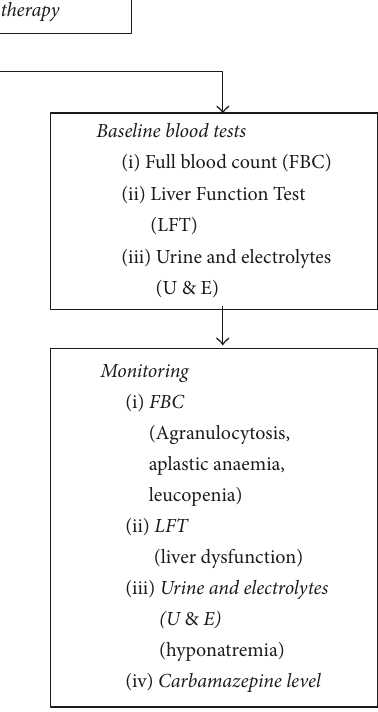
Figure 3: The figure shows the essential blood tests to be performed at the initial stage prior to prescription and following administration of